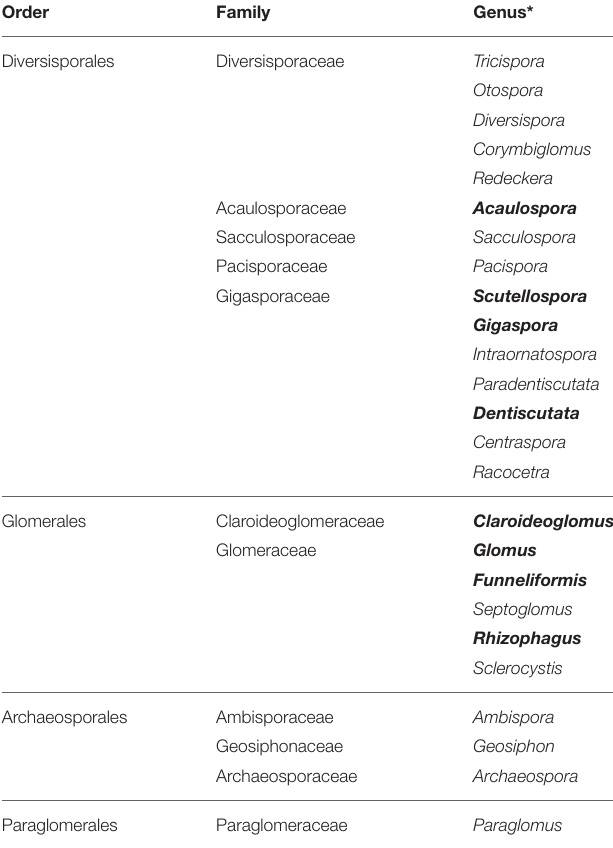
TABLE 1 | Classification of the phylum Glomeromycota according to Redecker et al. (2013).